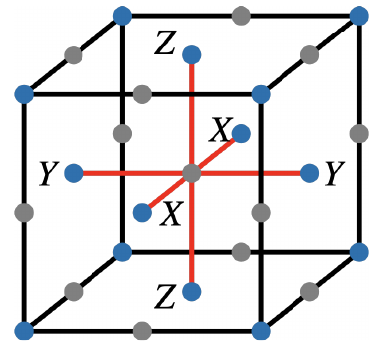
FIG. 6. Chamon’s fracton model on the FCC lattice. There is one qubit on every blue dot and the six-body stabilizer term, as shown, is defined on every vertex indicated by a gray dot.